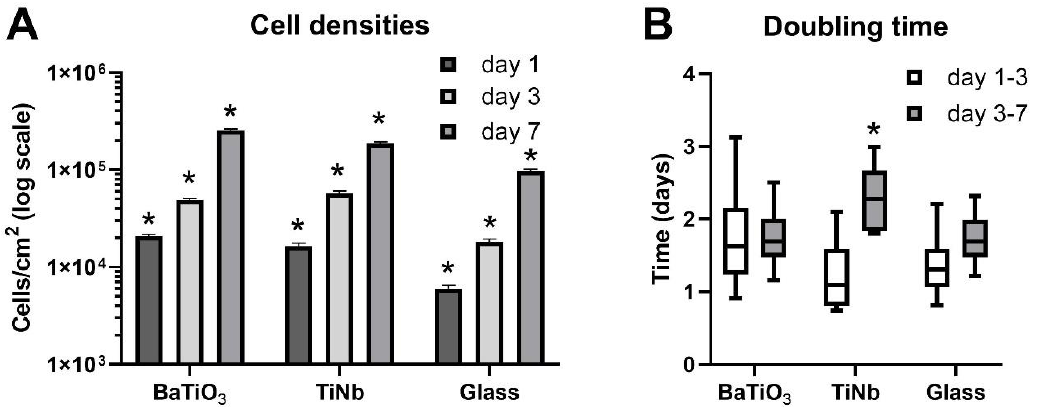
Figure 8. ( A ) Number of human osteoblast-like Saos-2 cells on day 1, 3 and 7 after seeding on Ti39Nb alloy coated with BaTiO 3 (BaTiO 3 ), on bare Ti39Nb alloy (TiNb), and on control microscopic glass coverslips (Glass). Mean + S.E.M. from three independent samples (in total from 48 to 52 microphotographs for each experimental group and time interval). ANOVA, Student-Newman-Keuls Methods. Asterisks above the columns indicate experimental groups significantly differing ( p ≤ 0.05) in cell number from all other groups on the same day of the culture. ( B ) Cell population doubling times of Saos-2 cells on the same samples, calculated between days 1 and 3 or between days 3 and 7 after seeding. Tukey boxplots, n = 24 for each plot. Bars within the boxes indicate medians; boxes indicate interquartile ranges (IQR); whiskers indicate the ranges of measurements within 1.5 × IQR. Asterisks above the plots indicate experimental groups significantly differing from all other groups on the same day of the culture (ANOVA, * p ≤ 0.01).